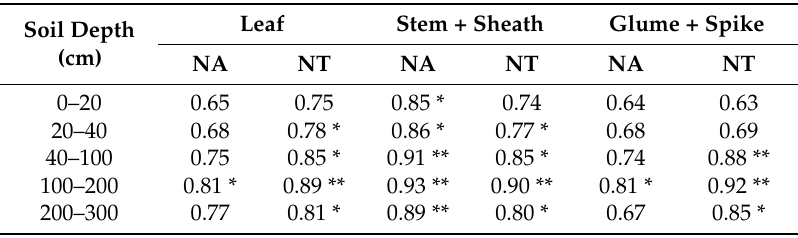
Table 4. Correlation coefficients between soil water storage at different soil depth and nitrogen accumulation and translocation in different organs before anthesis.